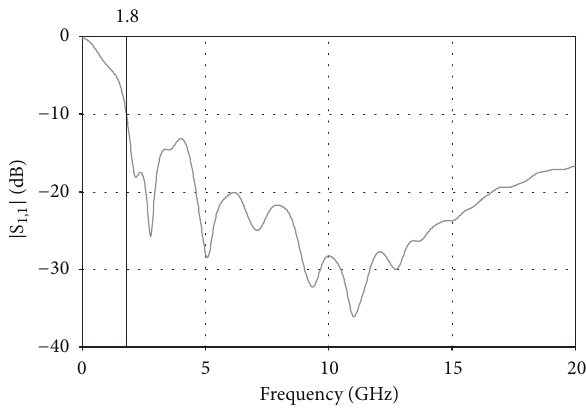
Figure 11: Reflection coefficient magnitude of a conical antenna with elliptical aperture and reflector.